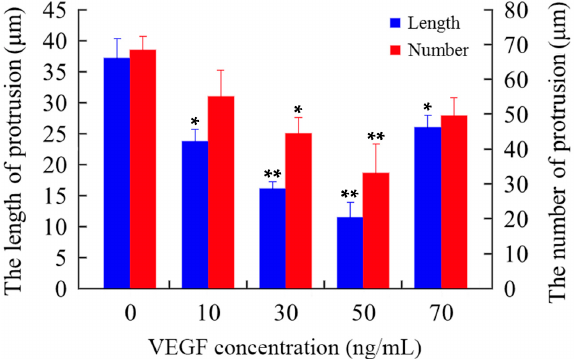
Figure 7. The filopodia on the surface of mDCs treated with different concentrations of VEGF. Cells were incubated with rhodamine phalloidin and photographed by confocal microscope. The blue columns represent the length of the filopodia, while the red columns represent the density of the filopodia. Compared with control group, * p < 0.05, ** p < 0.01.